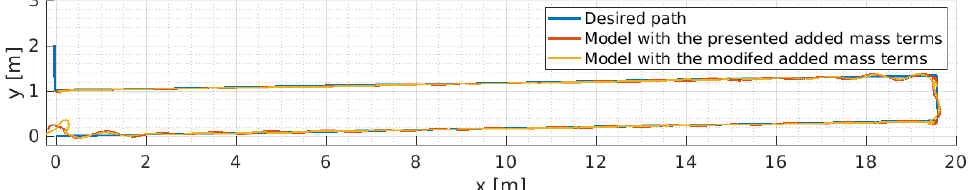
Figure 11. Simulation results for path following employing the modified controller with added mass terms multiplied by a factor of 2.